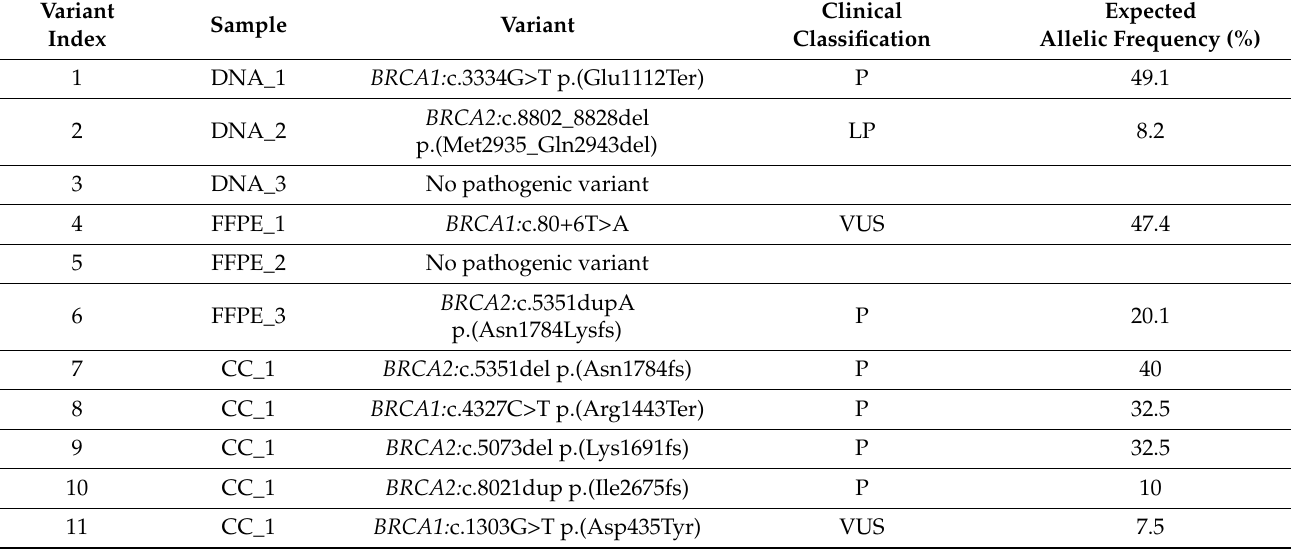
Table 3. Summary of BRCA1/2 variants present in the samples used in the